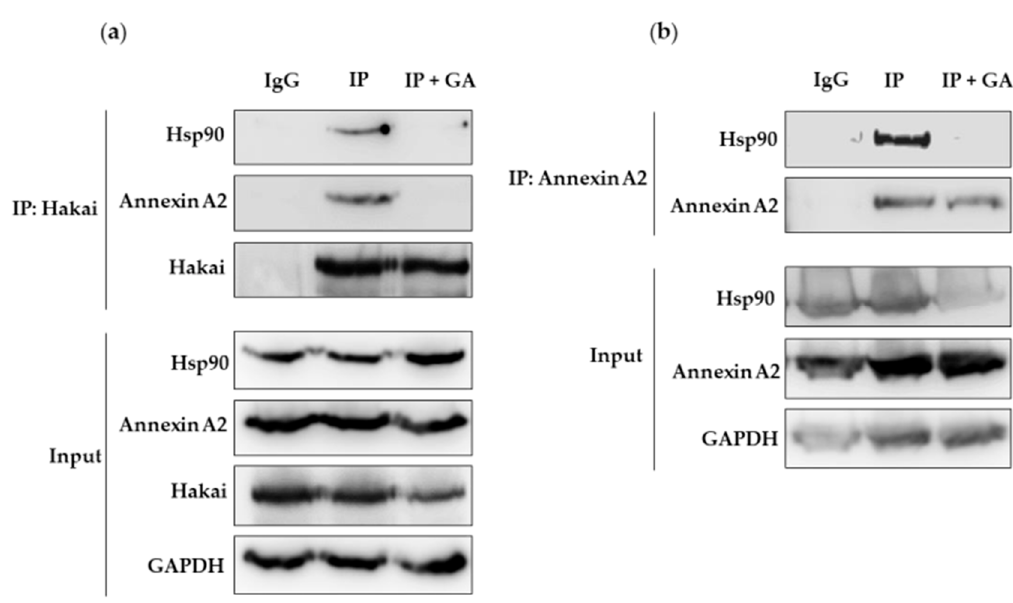
Figure 4. Geldanamycin treatment disrupts Hakai, Hsp90 and Annexin A2 interaction: HCT116 cell line was treated with 10 µM geldanamycin for 24 h. ( a ) Immunoprecipitation was performed by using Hakai antibody. Subsequent western blotting-analysis was performed using Hakai, Annexin A2, or Hsp90 antibodies. ( b ) Immunoprecipitation was performed by using Annexin A2 antibody and western blotting analysis was performed using Hakai and Hsp90 antibodies. GAPDH was used as protein loading